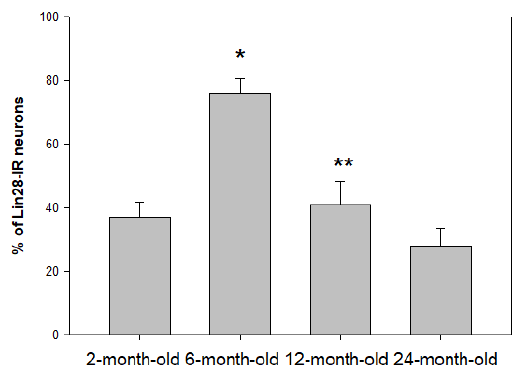
Figure 1. Immunostaining of Lin28-IR neurons in the VMH of 6-month-old ( a – c ), 12-month-old ( d – f ) and 24-month-old ( g – i ) male rats. Double labeling of neuronal marker NGreen ( a , d , g , green, left panel), Lin28 ( b , e , h , red, middle) and composite image ( c , f , i , right). Bar, 25 µm.